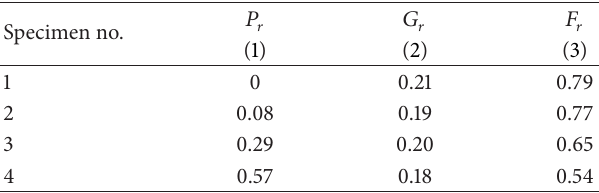
Table 2: Ratios of the pearlite area, the graphite particles area, and the ferrite area.